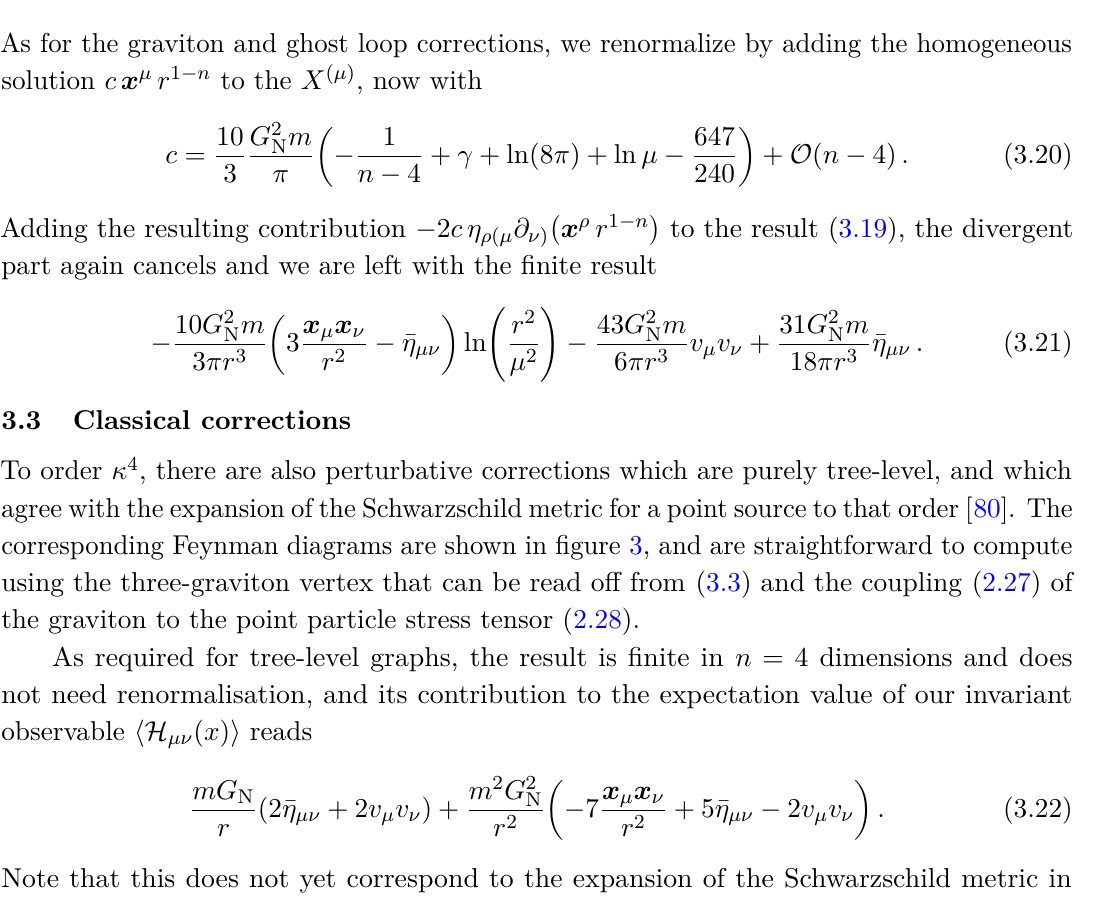
Figure 3. The classical contributions to hH µν ( x ) i up to order m 2 κ 4 ∼ m 2 G 2 the expansion of the Schwarzschild metric to that order, with the first one giving the well-known classical Newtonian gravitational